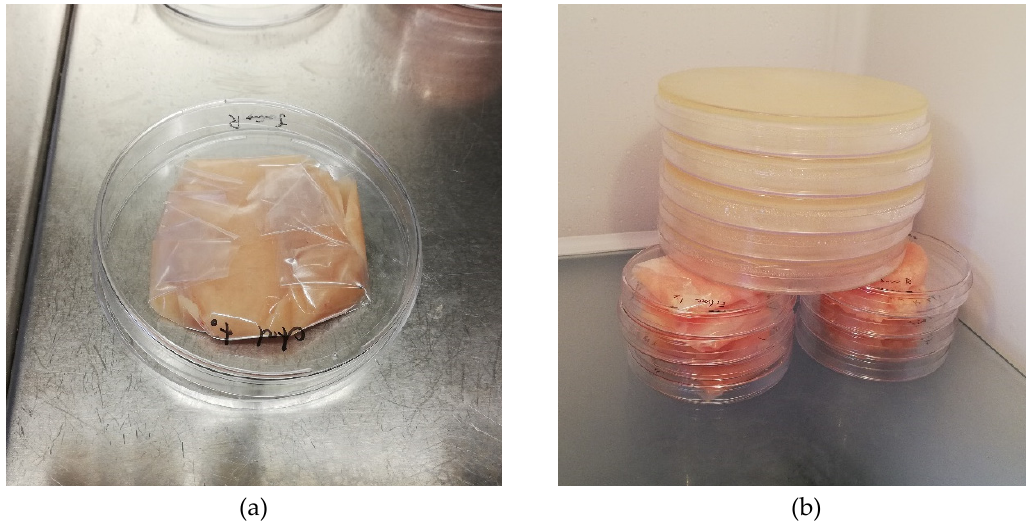
Figure 3. ( a ) Manual wrapping of the chicken breast paddies with electrospin-coated polypropylene (PP) film. ( b ) Storage of a small batch of samples for microbiological assay, with PP wrapped paddies on the left, and control (not wrapped) on the right.